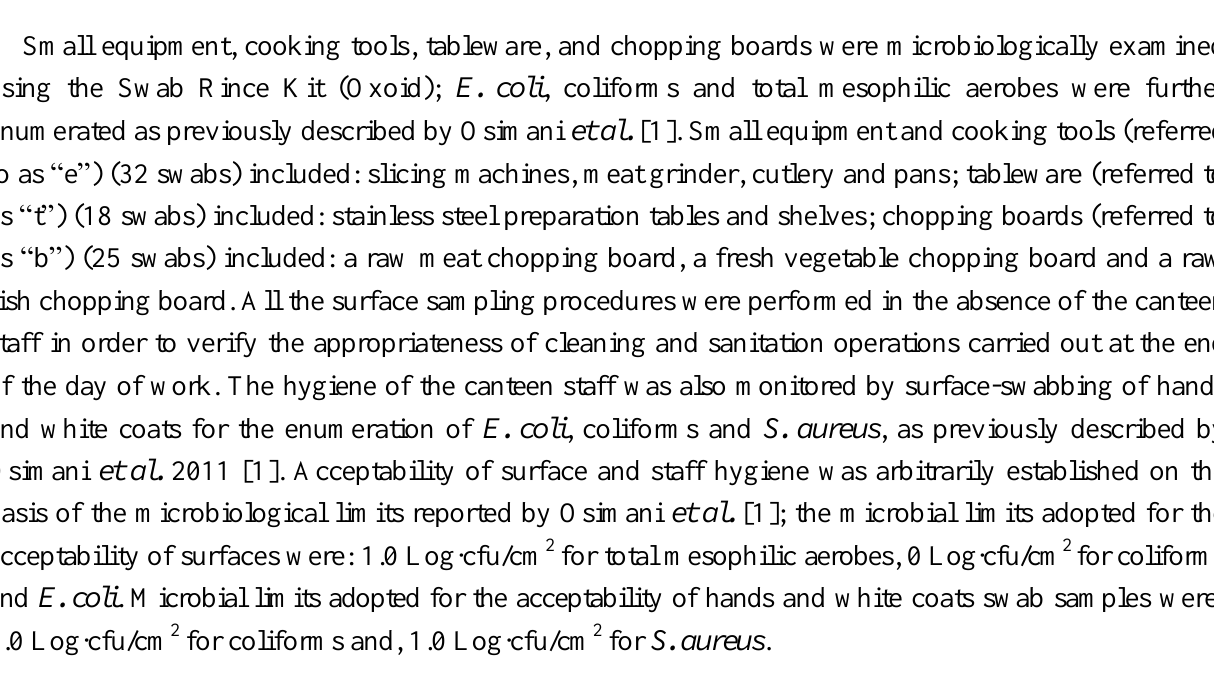
Table 1. Microbiological limits for food